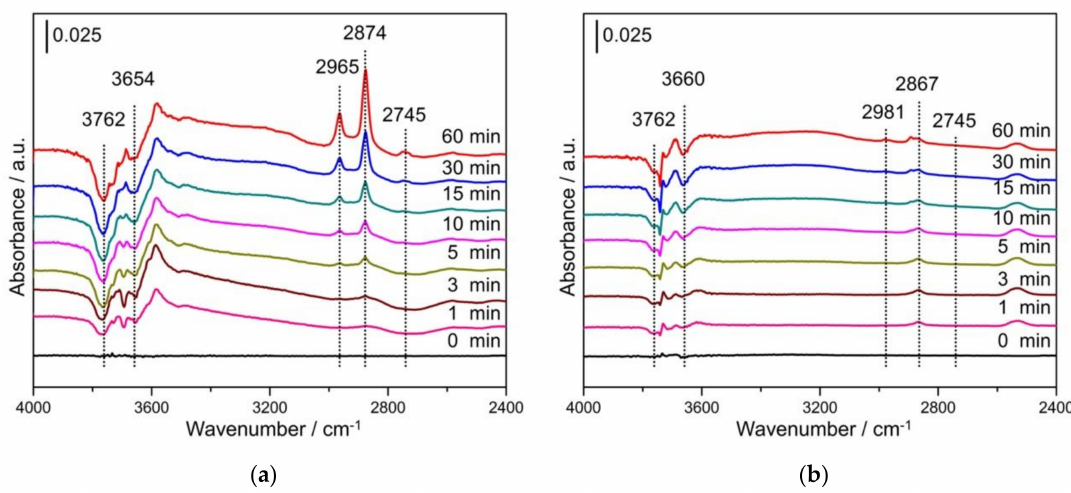
Figure 3. in situ DRIFT spectra of the ZrO 2 samples under CO flow. ( a ) m -ZrO 2 , ( b ) t -ZrO 2